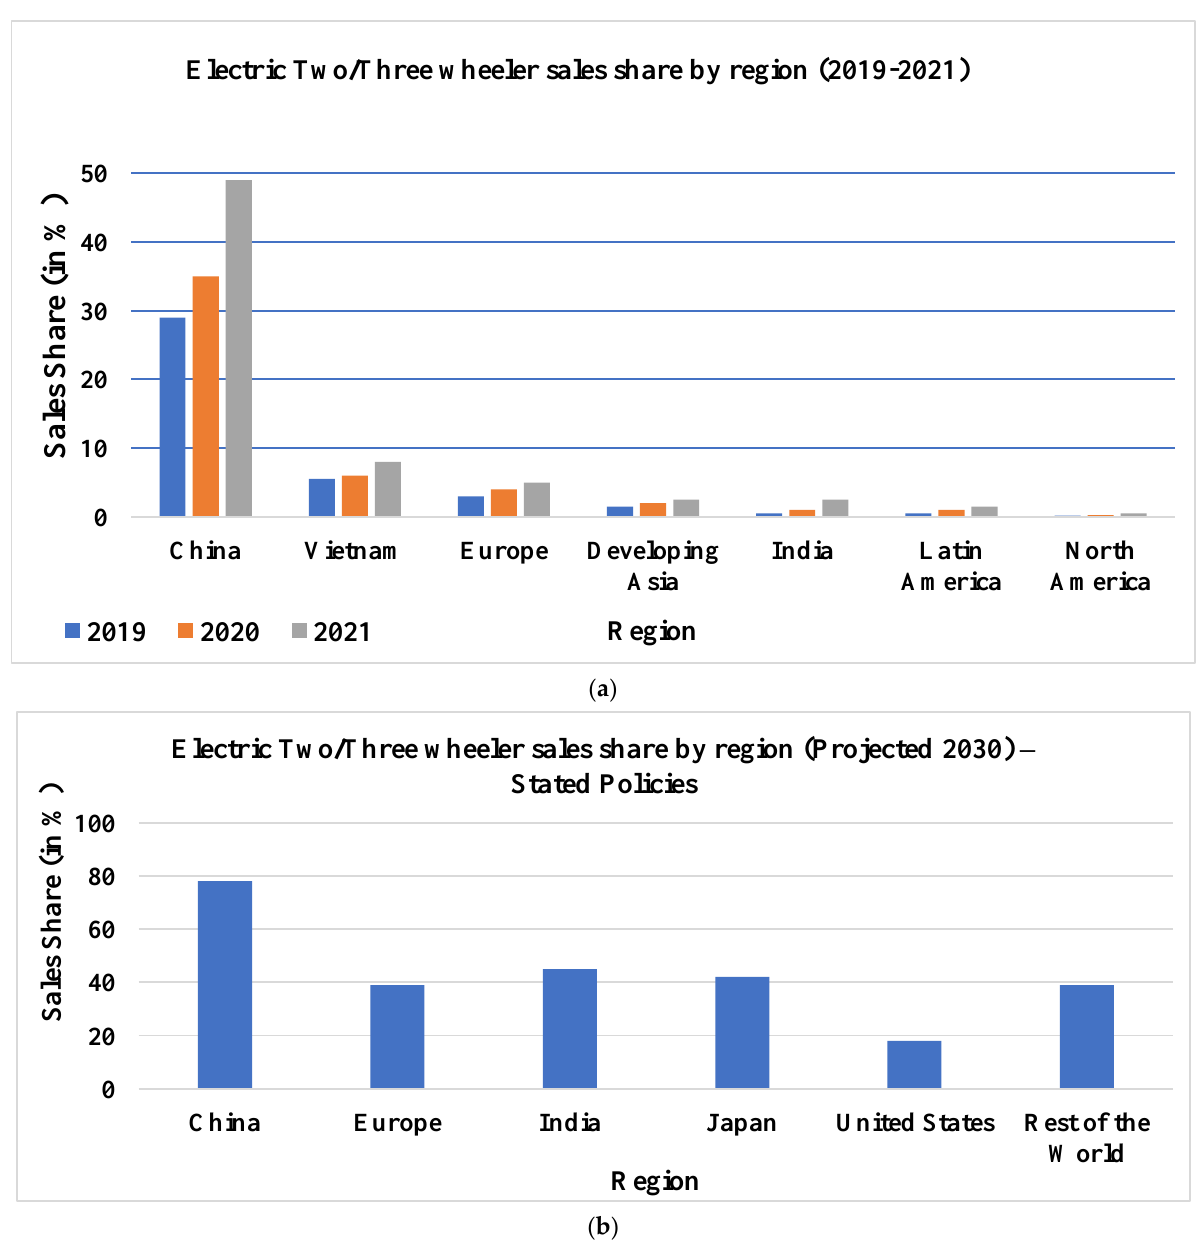
Figure 1. Electric vehicle sales trend in various regions. ( a ) Growth from 2019 to 2021 ( b ) Projected sales by 2030 [1].